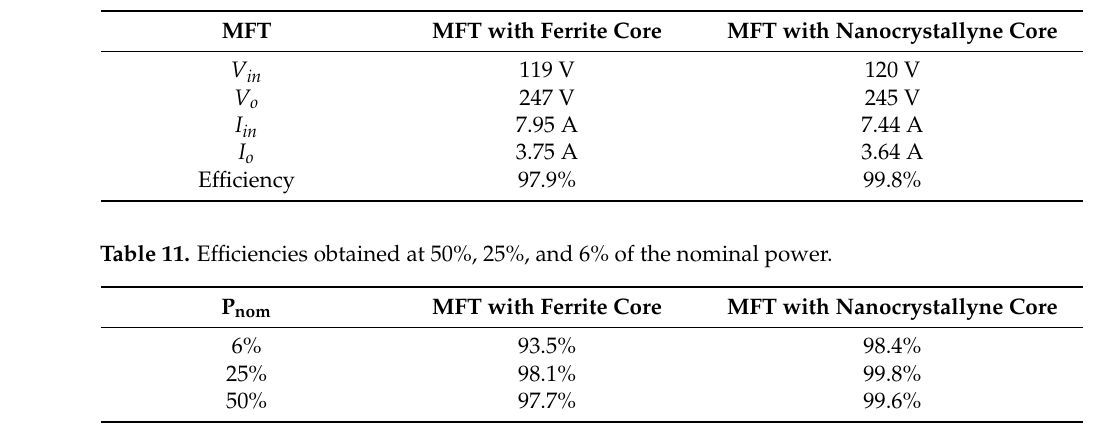
Figure 16. Thermography of the MFT-DAB lab prototype: ( a ) ferrite, ( b ) Nanocrystalline alloys.